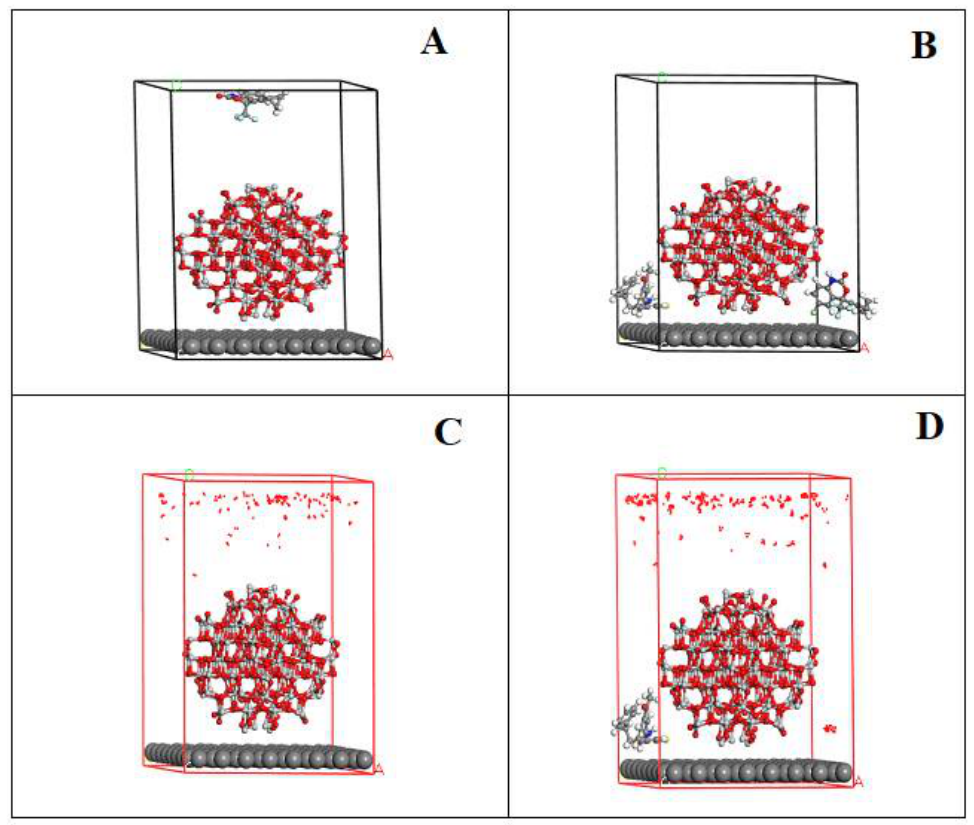
Figure 2. System conformations for ( A ) GCE/TiO 2 -NPs-EFV and ( B ) GCE/TiO 2 -NPs/Nafion-EFV, together with their respective distribution field maps ( C , D ) in a periodic cell.